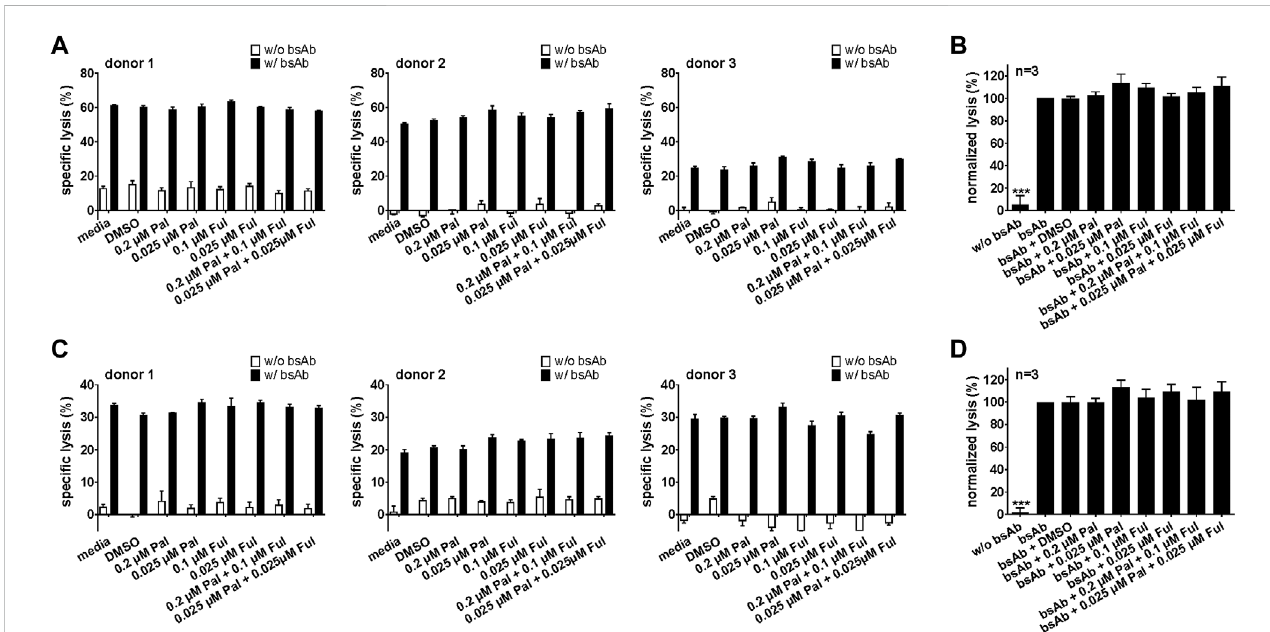
FIGURE 7 Effect of palbociclib and fulvestrant on bsAb-mediated tumor cell killing. T cells and (A,B) LNCaP-PSCA Luc+ or (C,D) PC3-PSCA/PSMA Luc+ cells were incubated with or without 30 nM of CD3-PSCA bsAb in the presence or absence of palbociclib and/or fulvestrant. After 8 h, tumor cell killing was calculated based on a luminescence-based killing assay. (A,C) Each diagram shows mean speci fi c lysis ± SEM of triplicates for one T cell donor. (B,D) Graphs summarize relative tumor lysis ± SEM of three different T cell donors. Speci fi c lysis in the presence of T cells and bsAb ( “ bsAb ” ) were equalized to 100%. (*** p ≤ 0.001 compared to control sample “ bsAb ” ; One-way ANOVA with posthoc Dunnett multiple comparison test).